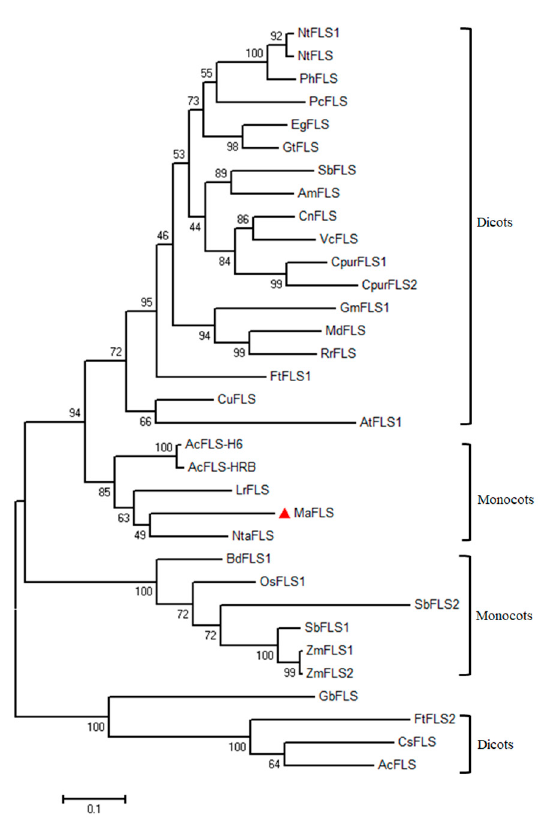
Figure 2. Phylogenetic analysis of MaFLS and other FLS proteins. The maximum-likelihood phylogenetic tree was generated using MEGA 6.0 software. Numbers at each interior branch indicate the bootstrap values of 1000 replicates. The bar indicates a genetic distance of 0.1. GenBank accession